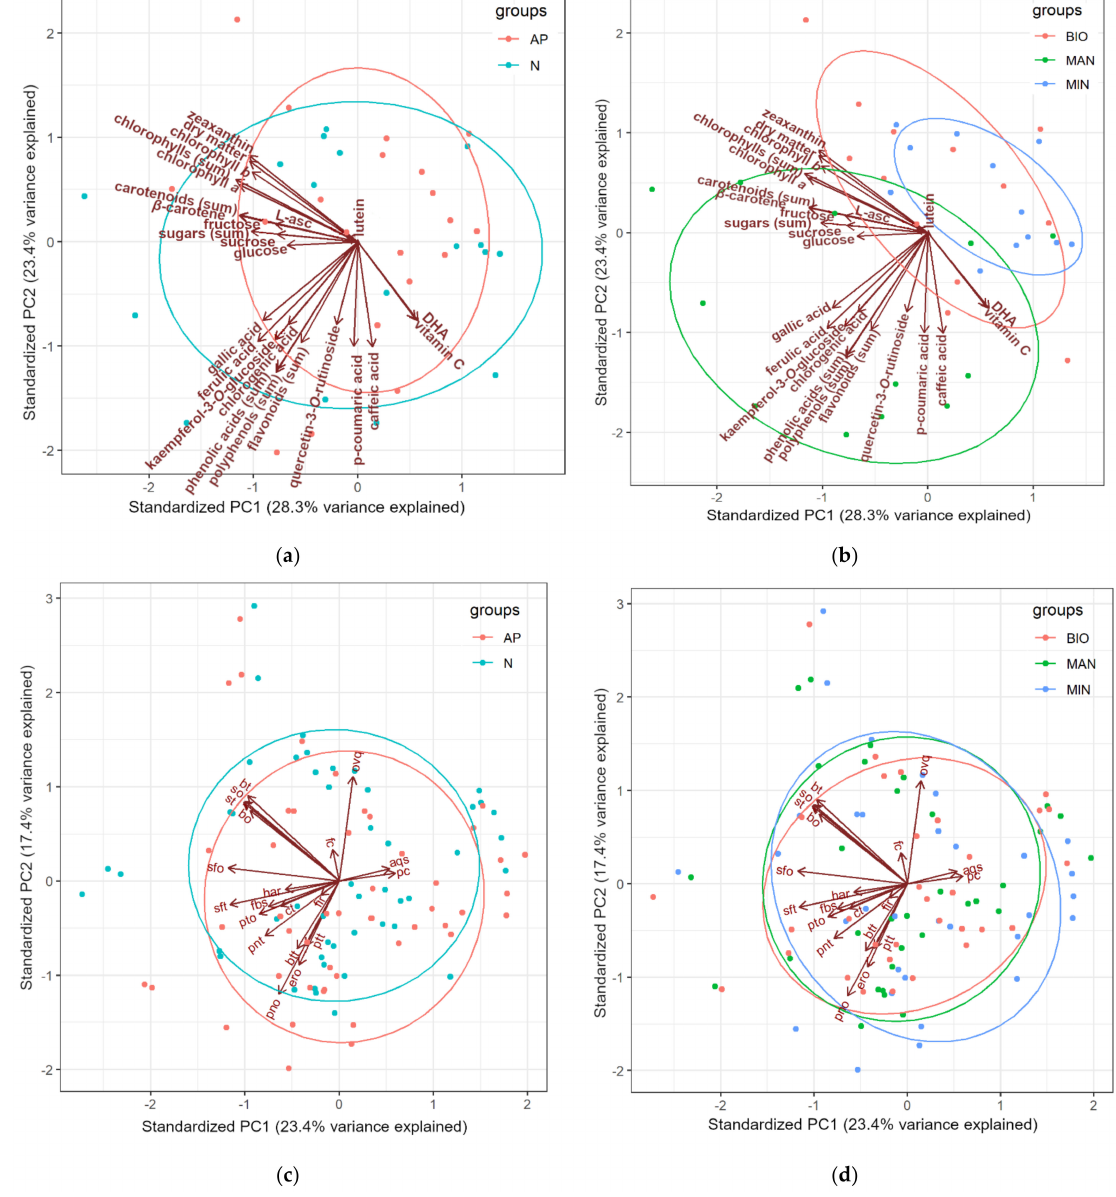
Figure 1. Principal component analysis (PCA) biplots of data on chemical composition, sugars and bioactive compounds of fruits of Astra Polka (AP) and Nimba (N) cultivars, ( a ) grown in horticultural system with commercial organic fertilizer (BIO), manure (MAN), and mineral (MIN) fertilizer, ( b ) as well as data on sensory attributes of fruits of ( c ) both cultivars and ( d ) grown with three fertilizers. PC1, the first principal component; PC2, the second principal component; Bo, buttery odor; pto, potato odor; so, sweet odor; sfo, sunflower odor; pno, pungent odor; ero, earthy odor; ptt, potato taste; sft, sunflower taste; bt, buttery taste; st, sweet taste; ct, cucumber taste; btt, bitter taste; pnt, pungent taste; pc, peel color; fc, flesh color; har, hardness; fir, firmness; aqs, aquosity; fbs, fibrousness; ovq, overall